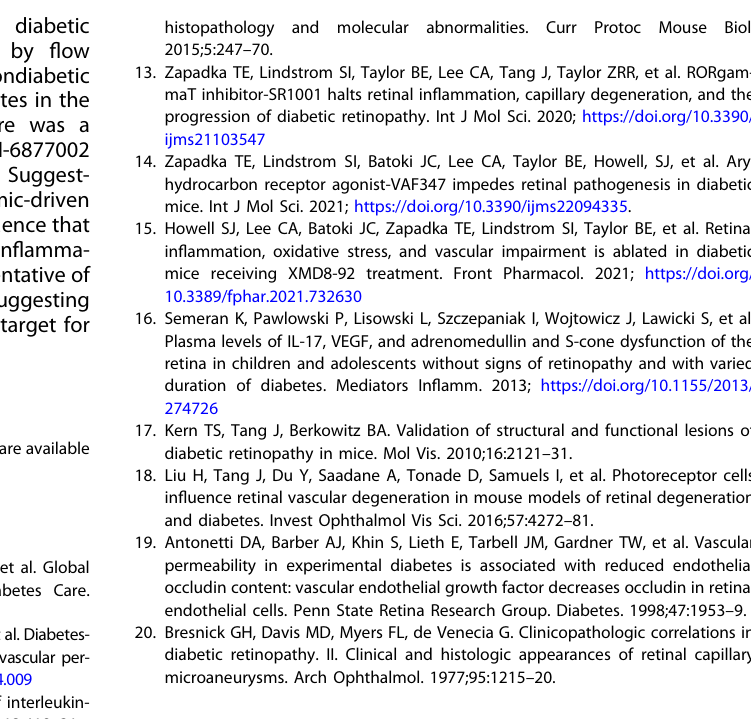
Fig. 2 Vascular leakage, capillary degeneration, and pericyte death in the retinas of diabetic mice. A Clinical data of hemoglobin A1c and body weight of mice 30-weeks after diabetes was con fi rmed. Treated mice received 30 injections of 20 μ M SMI-6877002. B Representative fl uorescent microscopy of vascular leakage (highlighted by two red boxes in leakage areas) in retinal cross-sections of outer nuclear layer (ONL), outer plexiform layer (OPL), and inner nuclear layer (INL) in untreated and treated non-diabetic and diabetic mice. Quanti fi cation of vascular leakage ( C ), and acellular capillaries ( D ) in each retina of untreated non-diabetic (light grey squares), untreated diabetic (light grey circles), treated non- diabetic (black squares), and treated diabetic (black circles) mice. Scale bars of images = 25 μ m. Each data point represents an individual retina from 7 different mice; 8-months post-diabetes. E Representative images of acellular capillaries (upper panel; 5 acellular capillaries in C57BL/6 DB and 1 acellular capillary in SMI-6877002 treated DB mice are highlighted), and pericyte ghosts (lower panel) in the retinal capillary beds of untreated and treated non-diabetic and diabetic mice. Black arrows highlight acellular capillaries (upper panel) and red arrows highlight pericyte ghosts (lower panel). Scale bars of images = 10 μ m. F Quanti fi cation of pericyte ghosts in retinal capillary beds ( n = 5/group). G Quanti fi cation of PDGFR β + pericytes in total retina per fl ow cytometry analysis ( n = 3/group). Error bars represent the SEM, and p -values were equated by two-way ANOVA analysis and unpaired t-test with Tukey ’ s post-hoc analysis. Data are representative of 2